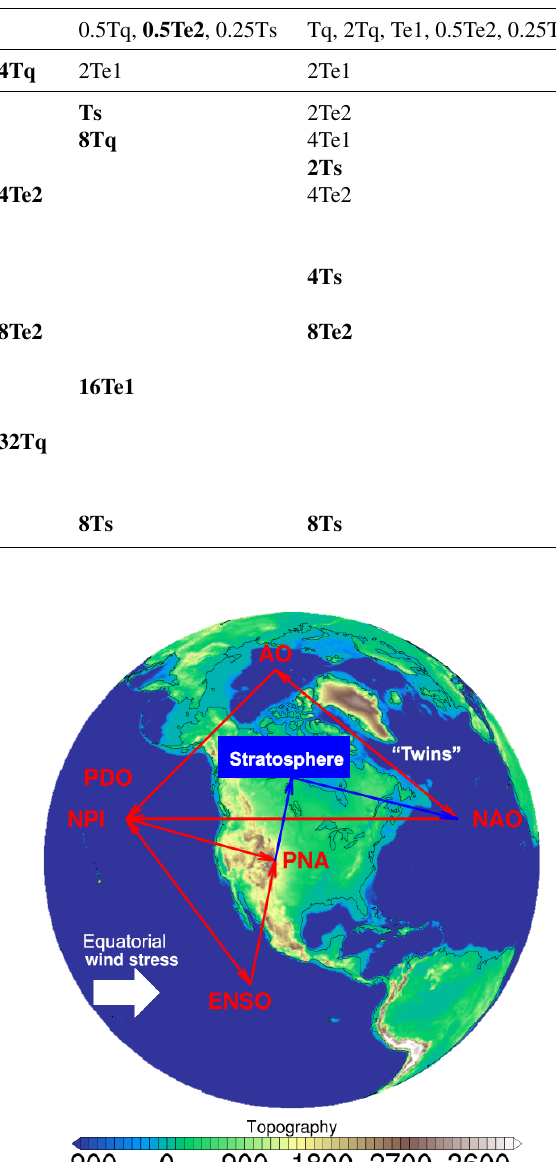
Table 4. The basic driving forces and their harmonic oscillations that are associated with the variability of climate mode indices at various timescales (periods) for all embedding dimensions. The entries in bold correspond to the highlighted numbers in Table 3. Scales Snino Ssoi Spdo Samo Snao Snaoi Te1/8, Te1/4